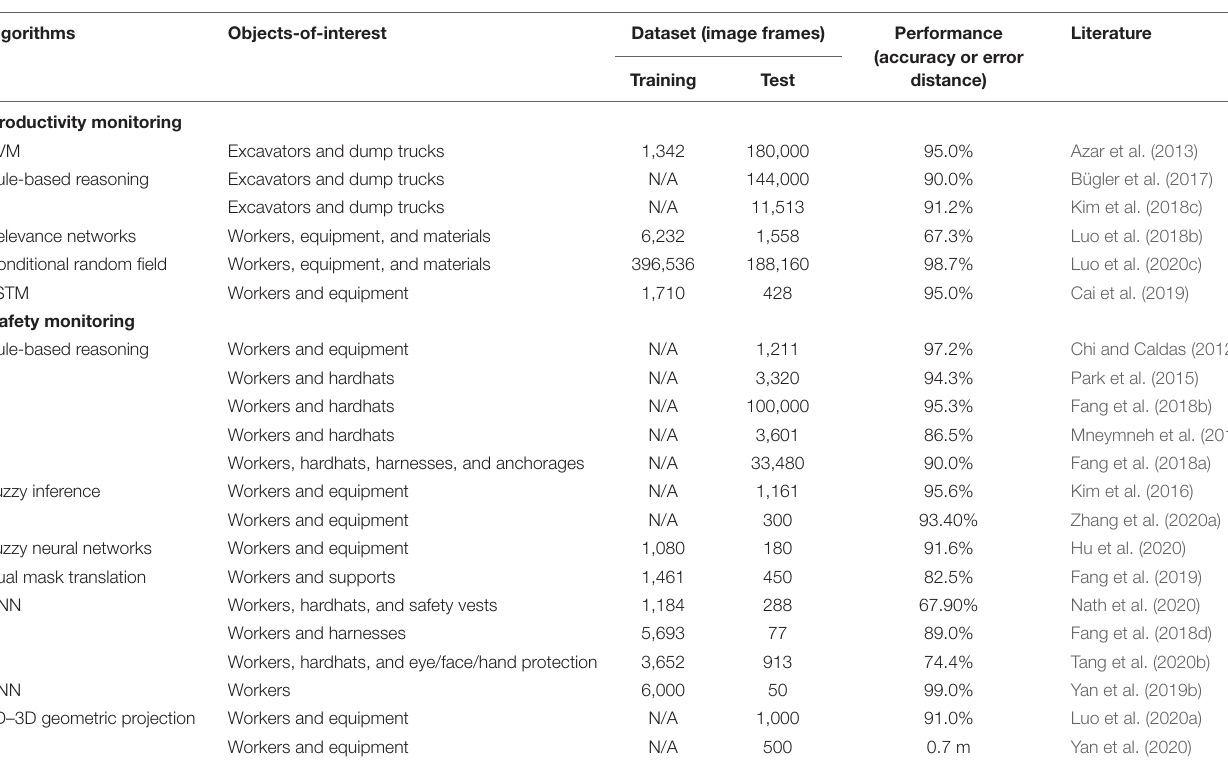
FIGURE 6 | Examples for the sequential working patterns of earthmoving excavators: (A) Sequential patterns of visual features. (B) Sequential patterns of operation cycles. Reprinted from Kim and Chi (2019) This article was published in Automation in Construction , Kim, J. and Chi, S. (2019) Action recognition of earthmoving excavators based on sequential pattern analysis of visual features and operation cycles. vol. 104, pp. 255–264, Copyright Elsevier (2019). TABLE 3 | Summary of existing interaction analysis algorithms in